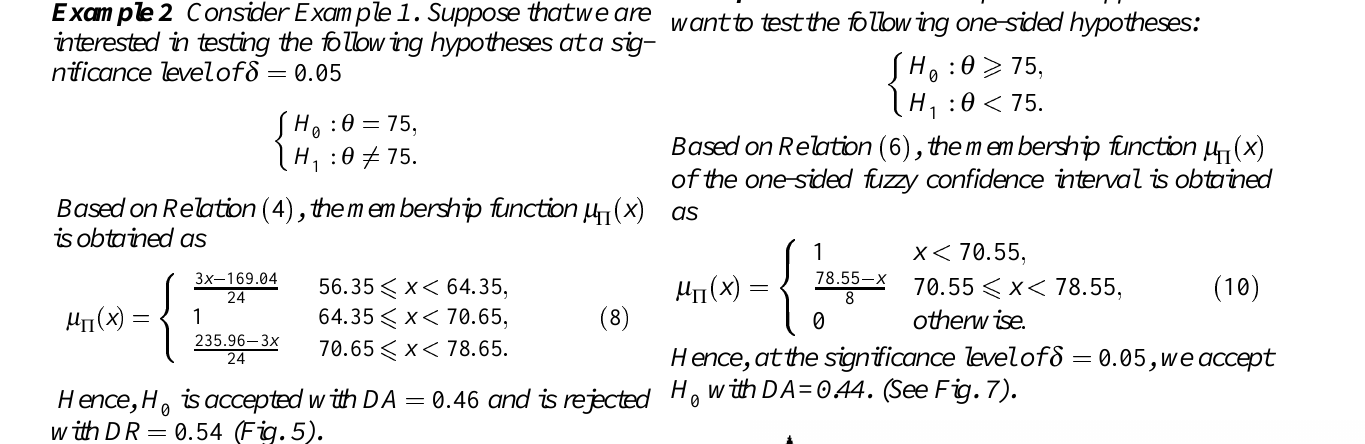
Fig. 6. H is accepted with DA=1. 0